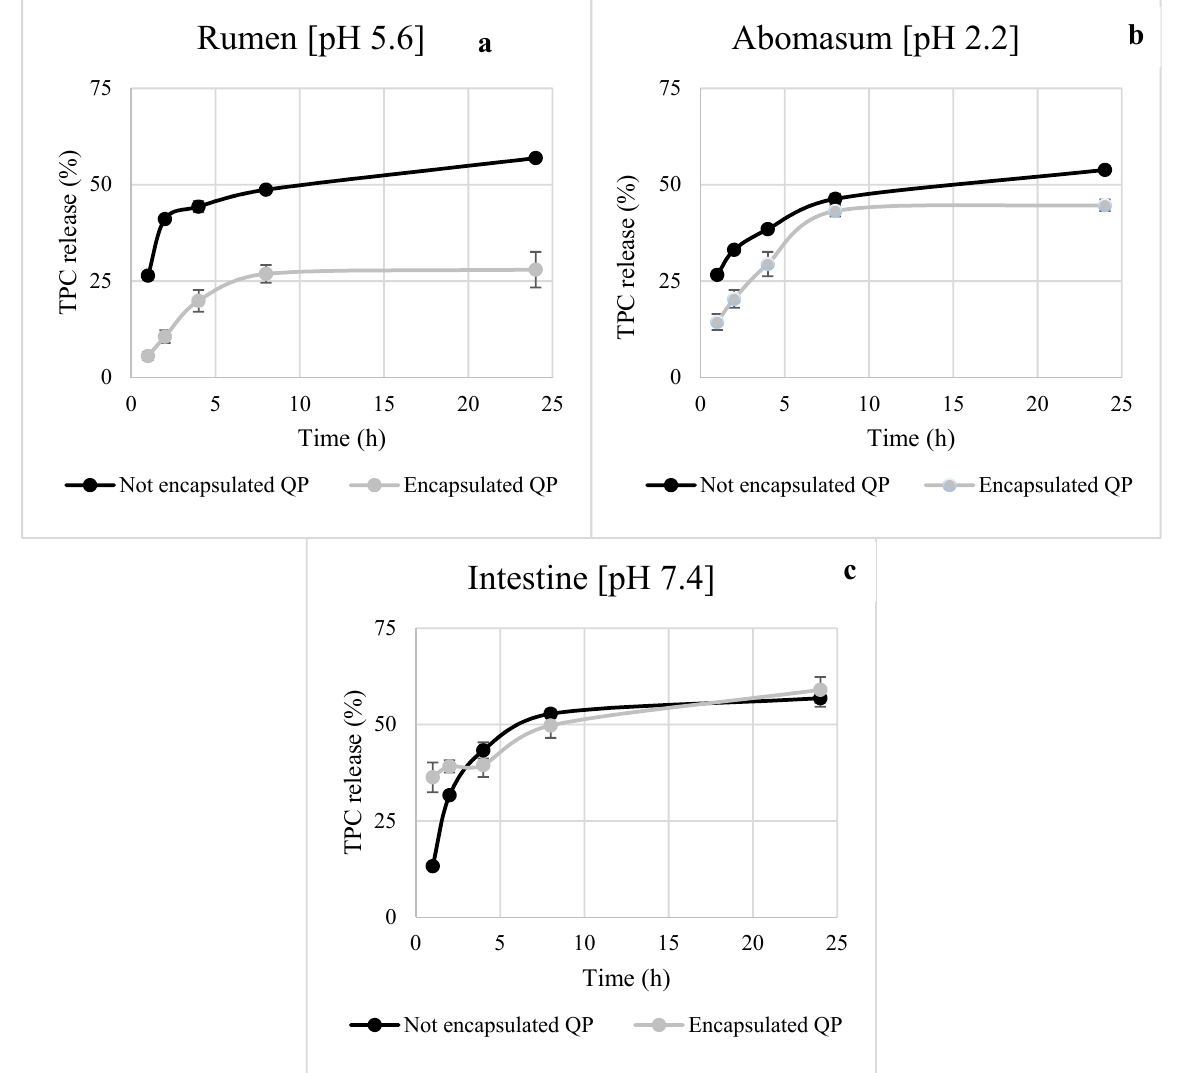
Figure 5. In vitro release profile of not encapsulated and encapsulated tannin extract in simulated rumen ( a ) abomasum ( b ) and intestinal ( c ) environment.